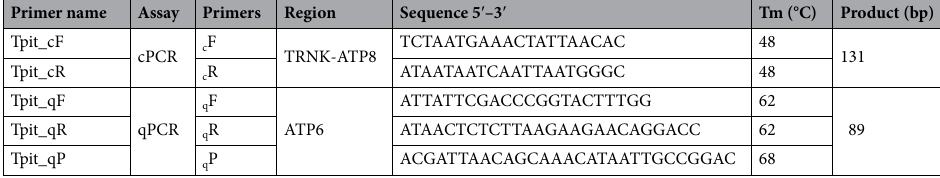
Table 1. Primer pairs and probes used in the study, the coding region, the primer sequence, the melting temperature, and the amplicon